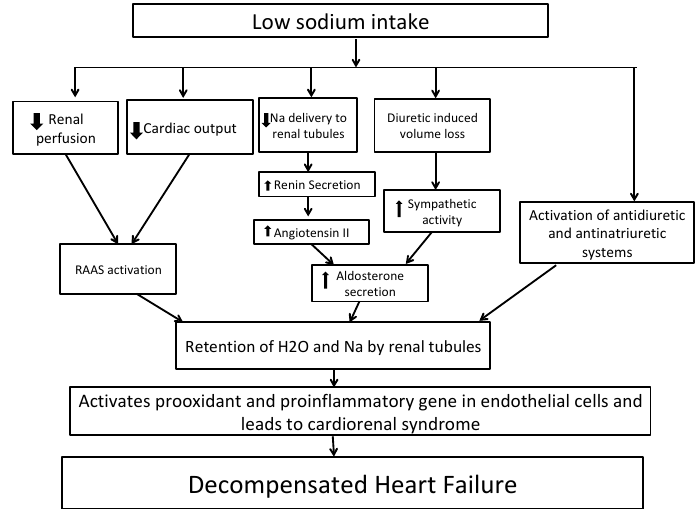
Figure 2. Potential mechanisms whereby dietary sodium restriction may worsen heart failure.